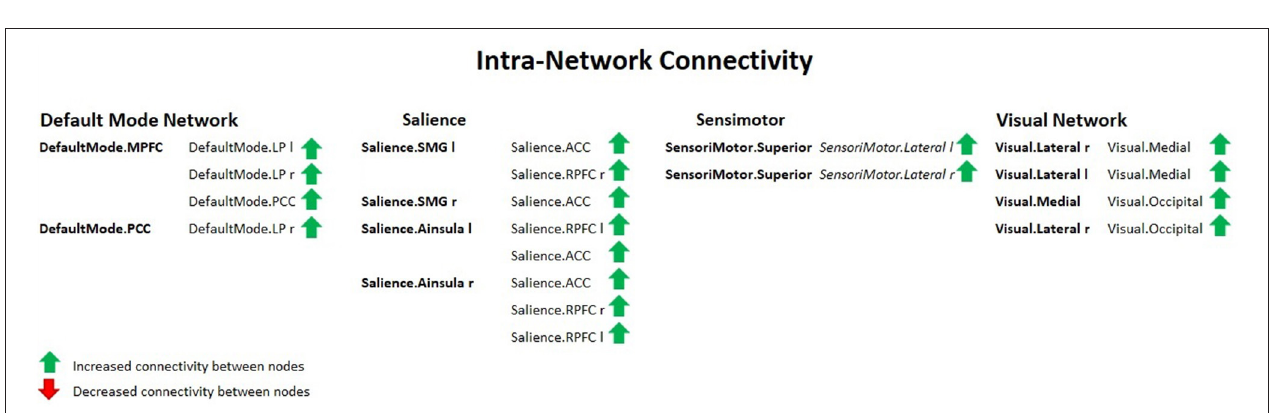
FIGURE 5 | Intra-network connectivity table showing increased FC between nodes in females with ageing, using spatial pairwise clustering (SPC) method.